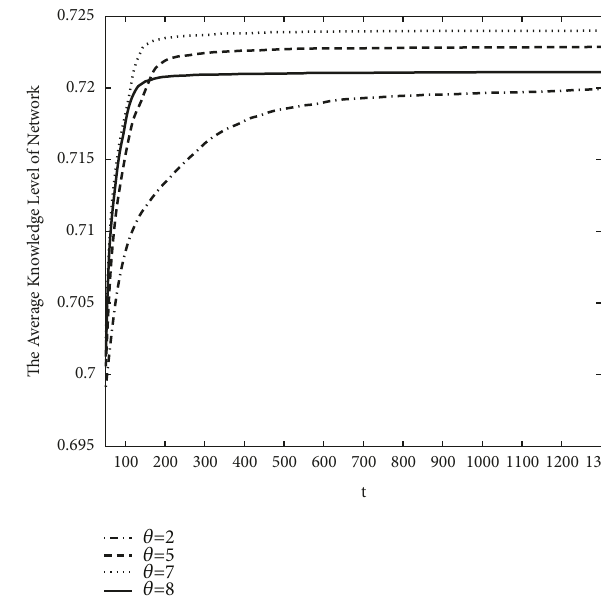
Figure 2: Network’s average knowledge level evolution diagram under different 𝛼 in knowledge externalization.